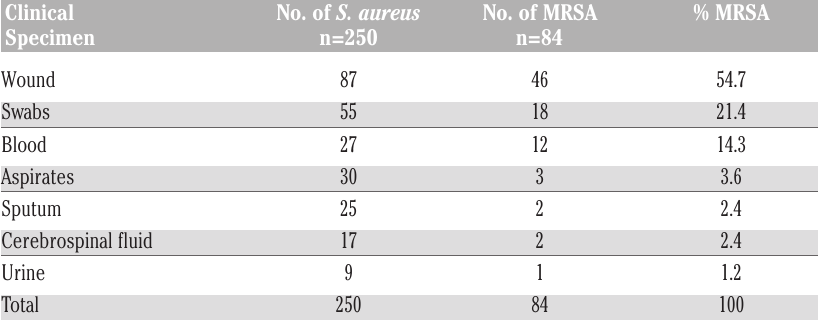
Table 1. Isolates of methicillin-resistant Staphylococcus aureus from different clinical specimen. Clinical